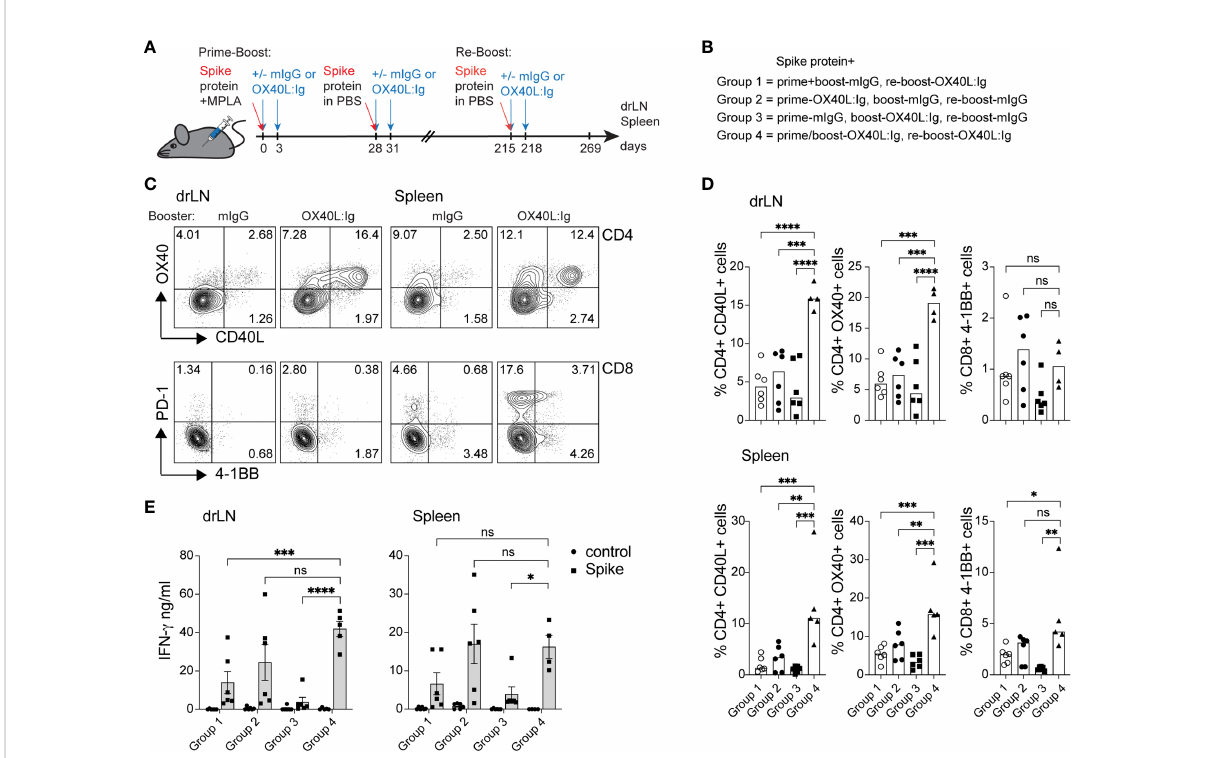
FIGURE 4 Booster immunization in combination with an OX40 agonist can increase T cell activation, antigen-speci fi c CD4 T cells, and cytokine production. Mice initially immunized with the spike protein+MPLA in the prime received the OX40L:Ig in prime, boost or both. Animals were then boosted 30 weeks later. (A) Schematic representation of the booster immunization with spike protein w/wo OX40L:Ig injections. (B) Description of the experimental group layout. (C, D) Cells from drLN and spleen were isolated 7 weeks after the booster and examined for antigen-speci fi c CD4 and CD8 T cells. (C) Flow cytometric analysis of the expression of CD40L and OX40 on CD4 T cells (top) and PD-1 and 4- 1BB on CD8 T cells (bottom) after overnight incubation with the spike-protein (one representative mouse from each group is shown). Numbers in each quadrant indicate percent positive cells. (D) Bar graphs showing the summary of the percentages of CD40L+ CD4, OX40+ CD4 and 4- 1BB+ CD8 T cells in the drLN and spleens of mice receiving booster immunizations ± OX40L:Ig. (E) Cytokine assessment for IFN- g and IL-2 in the supernatant of 3-day cultures from drLN and spleen. N=5-6 animals per group, 1 of 2 experiments is shown. Each individual symbol in the bar graphs represents a single mouse. Bars indicate mean ± SEM. One-way ANOVA with Tukey ’ s multiple-comparisons test. *P<0.05, **P<0.01, ***P<0.001, ****P<0.0001, ns, not signi fi